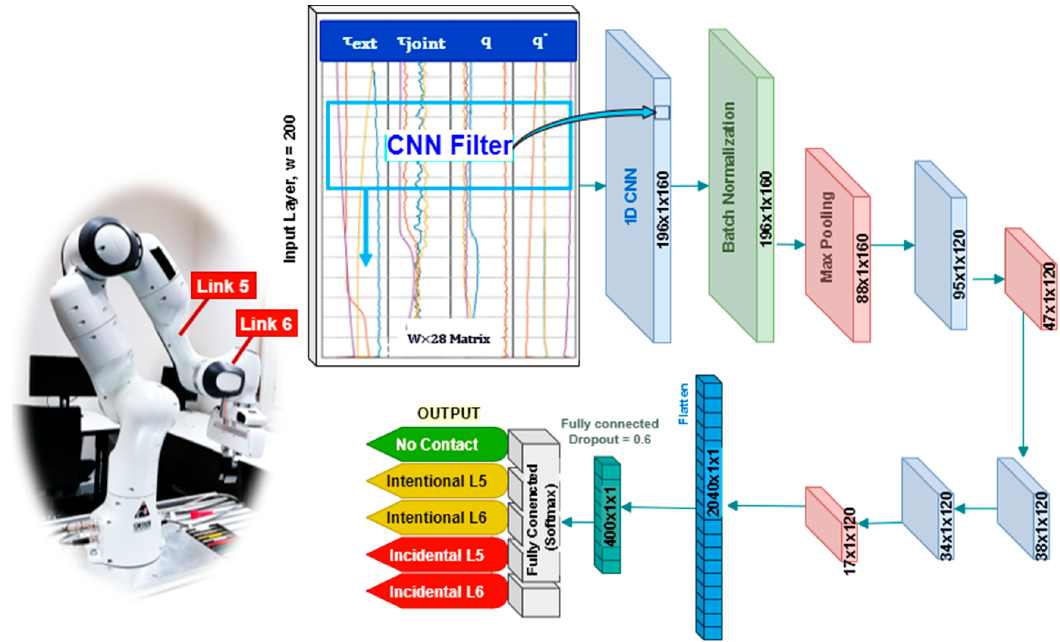
Figure 2. Contact detection network diagram.